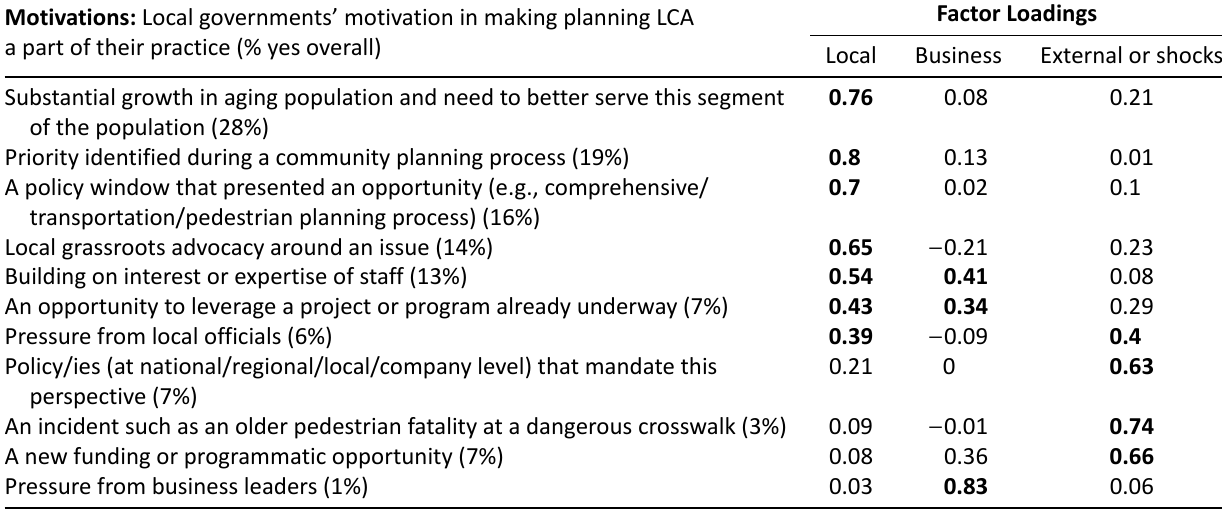
Table 2. Factor analysis of LCA motivations. Source: International Planner Engagement Survey (AARP, 2017). Motivations: Local governments’ motivation in making planning